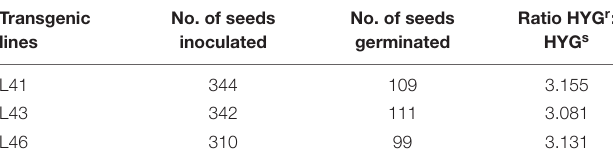
TABLE 2 | Segregation ratio of